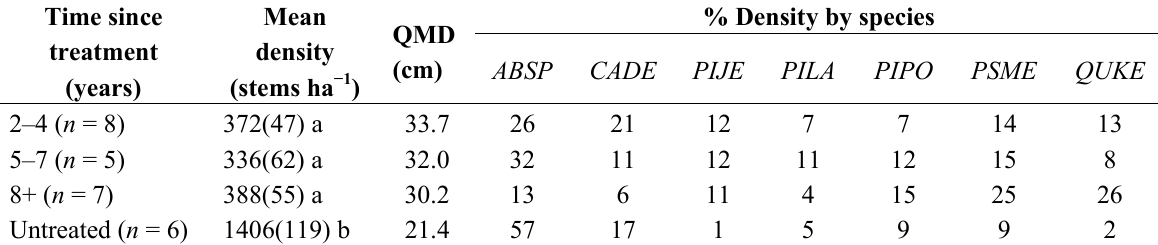
Table 1. Mixed conifer mean stand density (standard error), quadratic mean diameter (QMD), and mean contribution of each tree species to total density for each time-since-treatment category. Different letters indicate significant difference in means between groups (Tukey’s HSD multiple comparison test, p < 0.05). Calculations include all trees with diameter at breast height ≥ 2.5 cm. Tree species codes are ABSP : Abies concolor and A. magnifica (combined); CADE : Calocedrus decurrens ; PIJE : Pinus jeffreyi , QUKE : Quercus kelloggii . Species composing less than 1% of total density are not included in % density calculations.